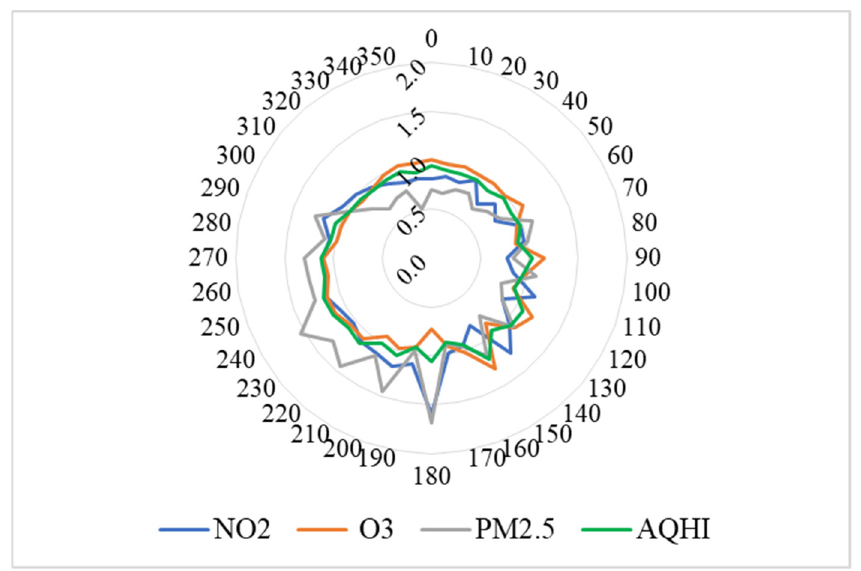
Figure 9. Directional AQHI and air pollutant concentrations, normalized to the perspective overall mean value, respectively. mean value,